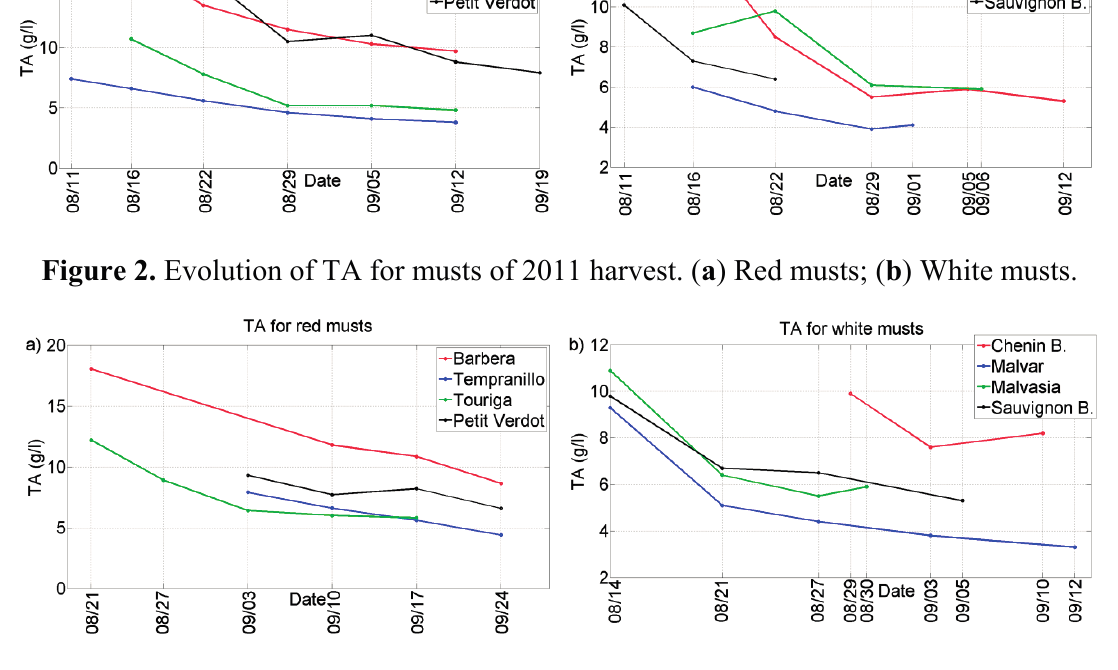
Figure 3. Evolution of TA for musts of 2012 harvest. ( a ) Red musts; ( b ) White musts.